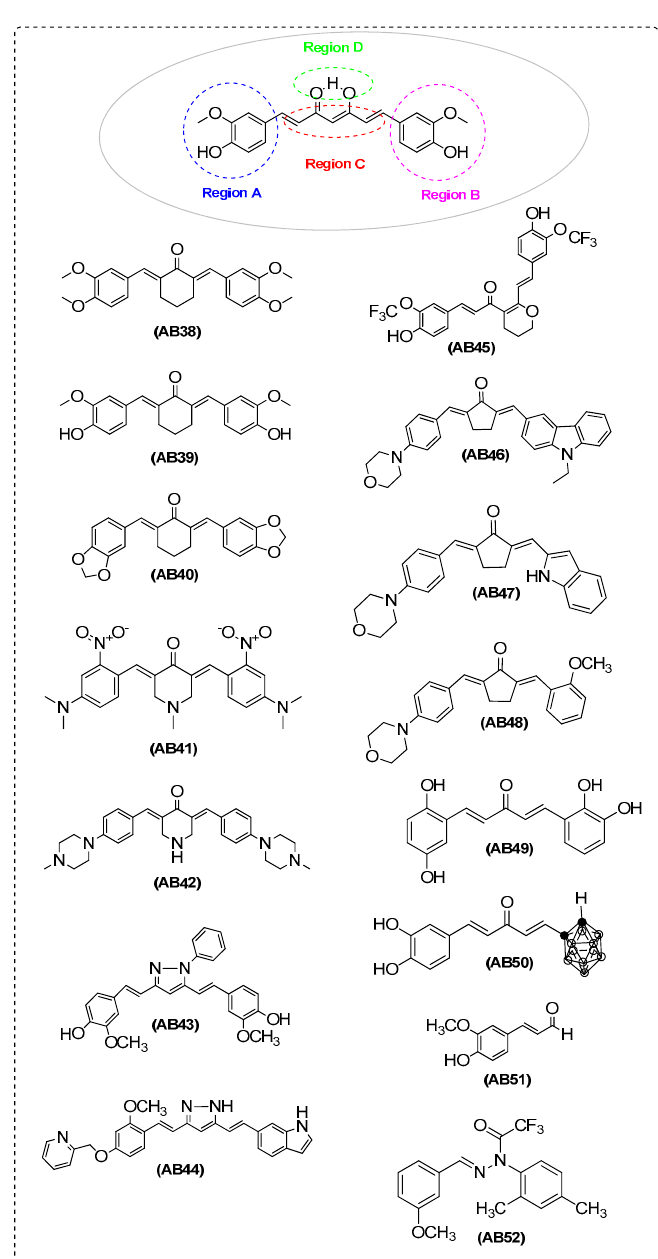
Figure 3. of amyloid- β aggregation. Figure 3. Inhibitors of amyloid- β